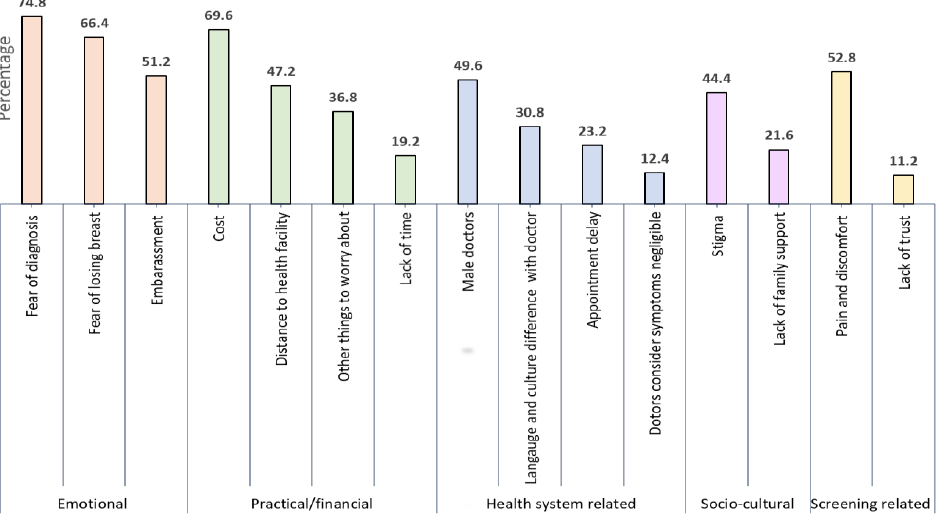
Figure 2. Perceived barriers reported by women expressed in percentage ( n = 250).